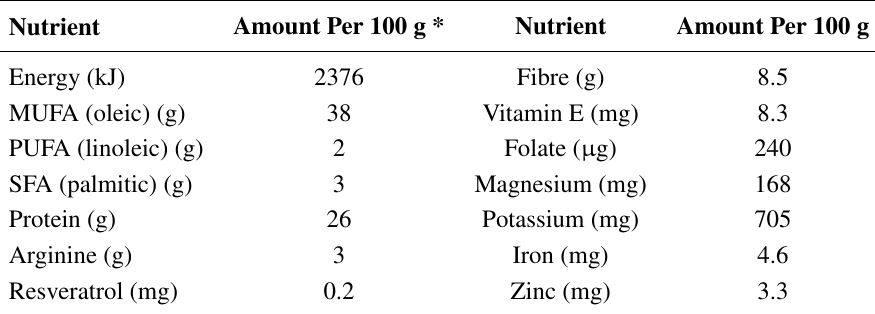
Table 1. Nutrient content of high oleic